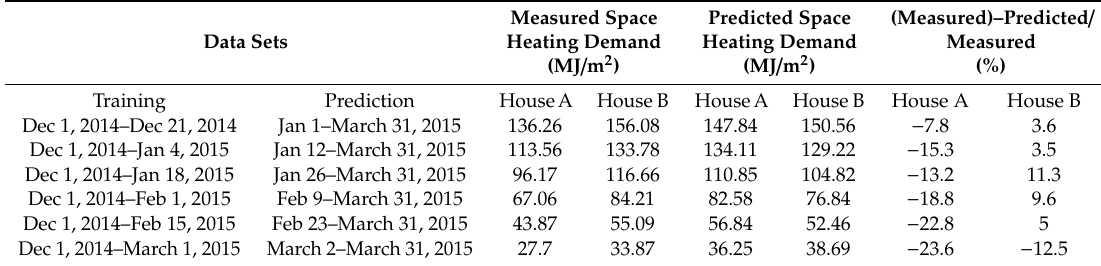
Table 8. Measured versus predicted total heating energy demand for houses A and B with the augmented window